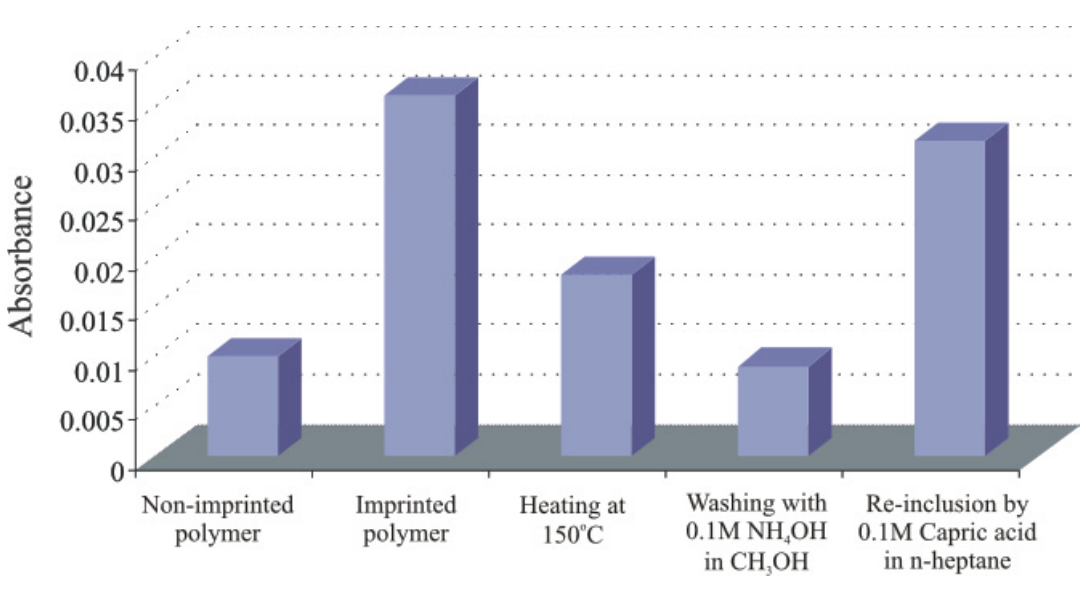
Figure 4. FTIR studies to monitor the removal and re-inclusion of capric acid in aminopropyl- triethoxy silane polymer.